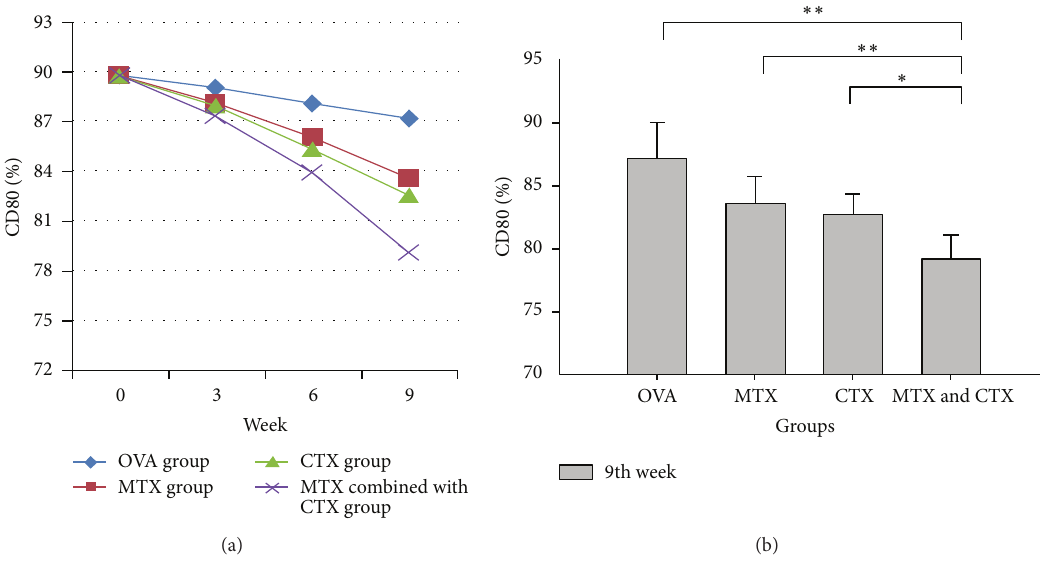
Figure 2: (a) Dynamic changes of CD80 expression in each group. (b) Comparison of CD80 expression in each group on 9th week. Data represented one of at least three independent experiments with 5 mice per group ( ∗ 𝑃 < 0.05 , ∗∗ 𝑃 < 0.01